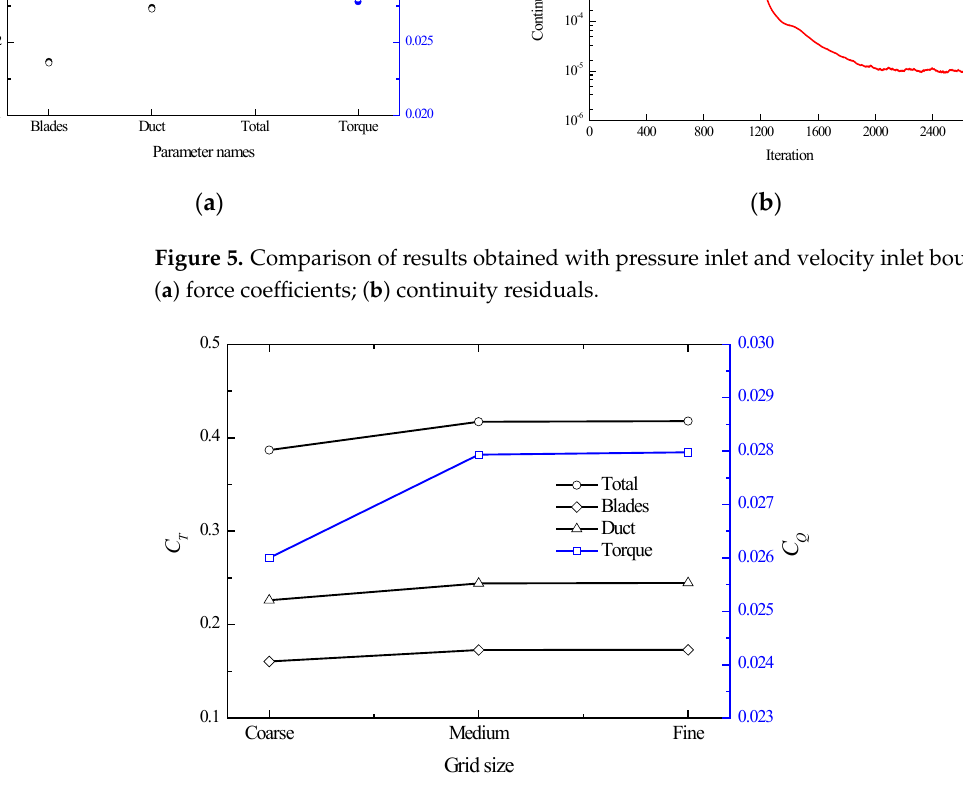
Figure 6. Coefficients calculated by different grid densities, Grunwald’s model in Table 2. Comparison between CFD results of medium mesh and experimental values; Grunwald’s model in hovering.